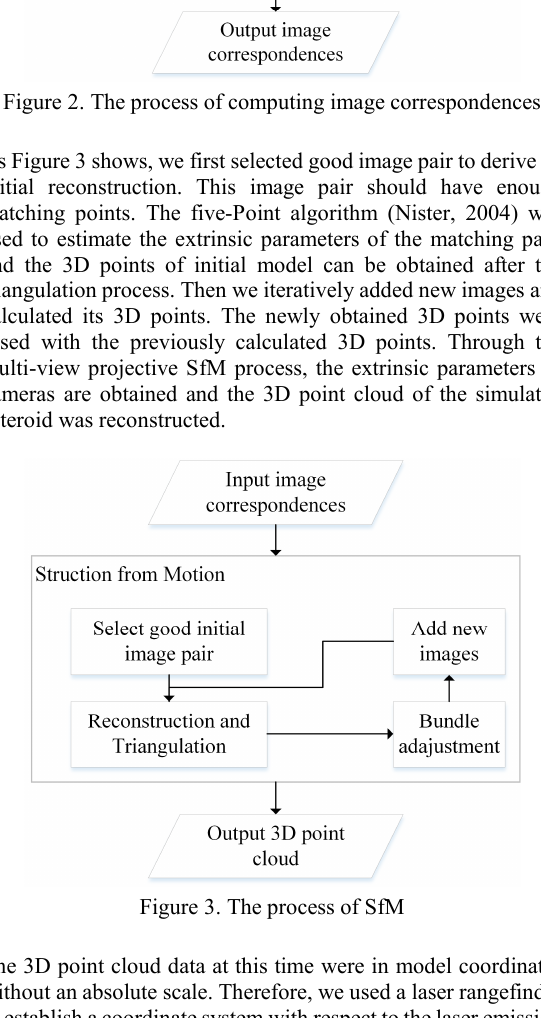
grid, so as to generate the